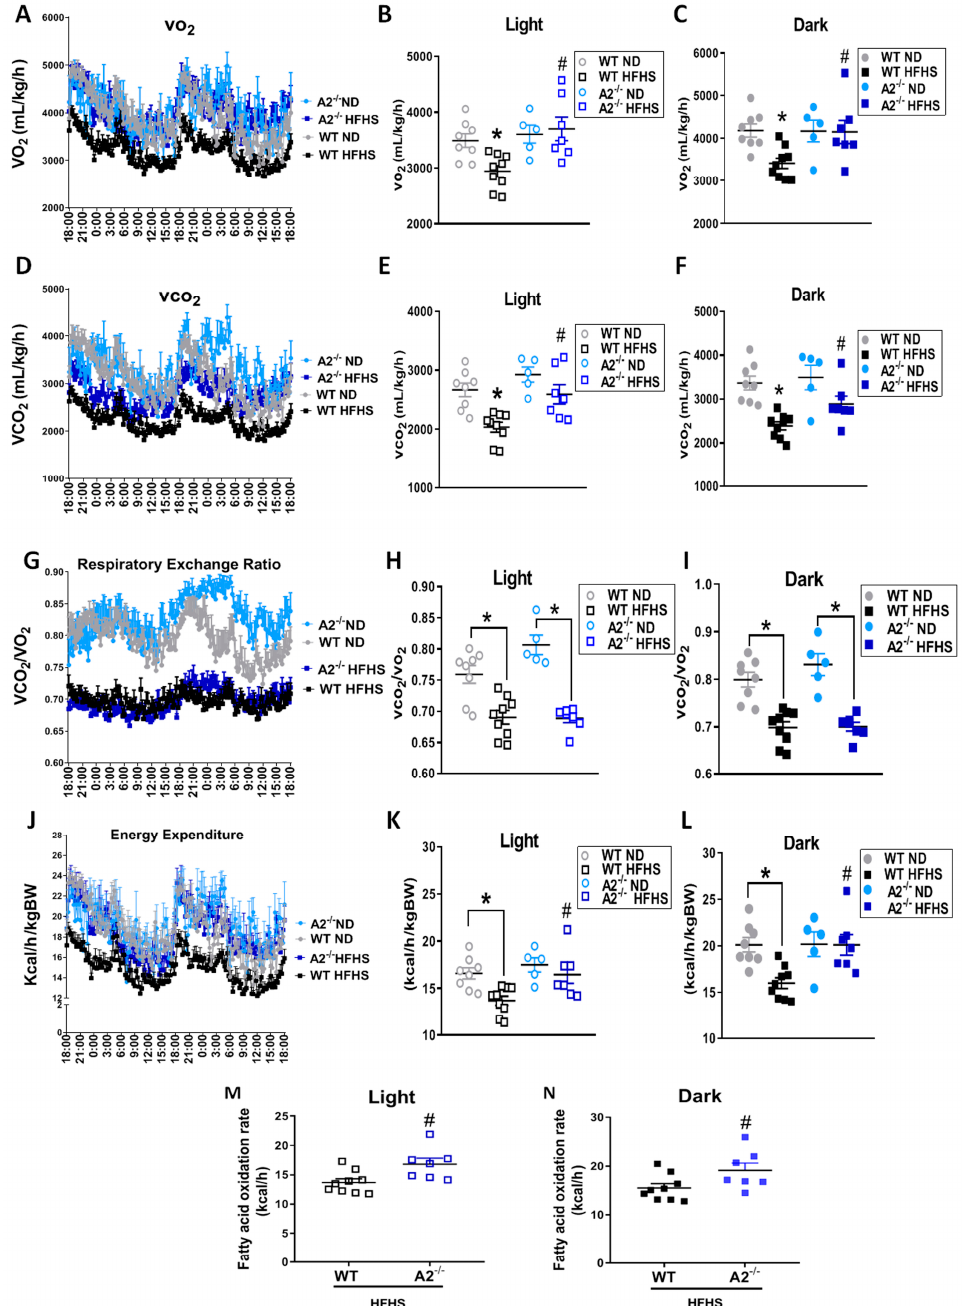
Figure 2. A2 deletion improves whole body metabolism. Oxygen consumption (VO 2 ) ( A – C ) and carbon dioxide produced (VCO 2 ) ( D – F ), represented as mL/kg/h; respiratory exchange ratio calculated as VCO 2 /VO 2 ( G – I ) and energy expenditure ( J – L ) calculated as kcal of heat produced/h/body weight, fatty acid oxidation rate calculated as kcal/h during light and dark cycles ( M , N ). Values are means ± SEM; n = 5–9 mice/group. * P < 0.05 when compared to ND-fed mice within the same genotype, # P < 0.05 when compared to WT on the same diet.